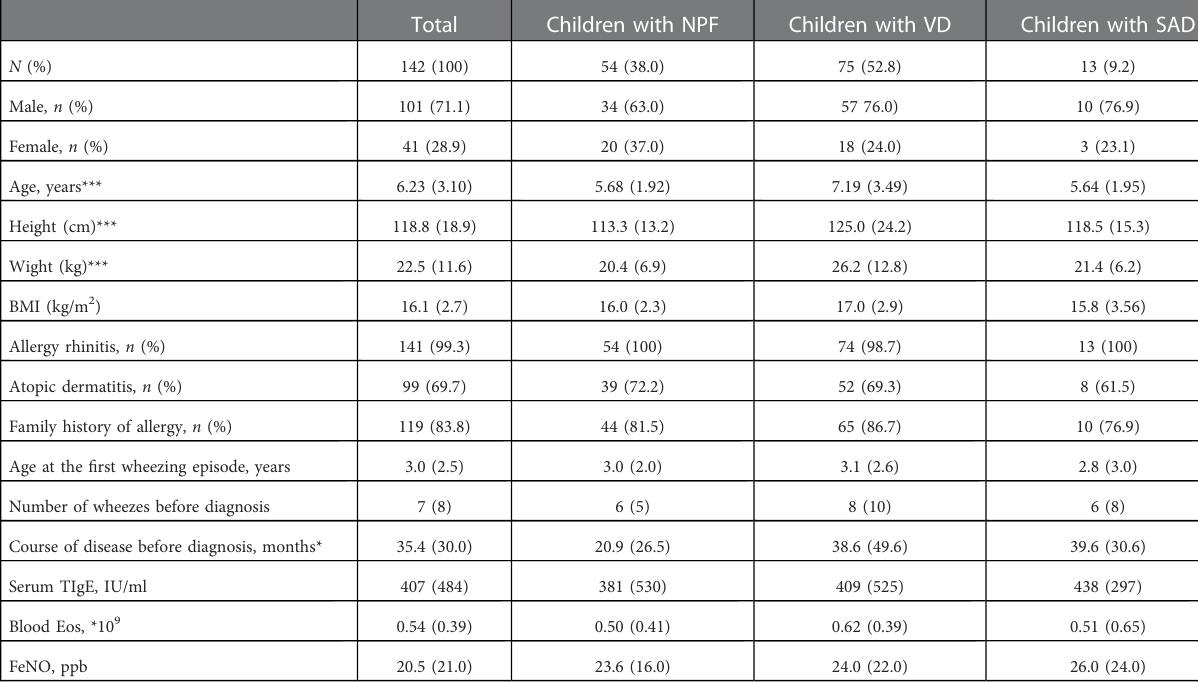
TABLE 1 Demographics and baseline clinical characterization.